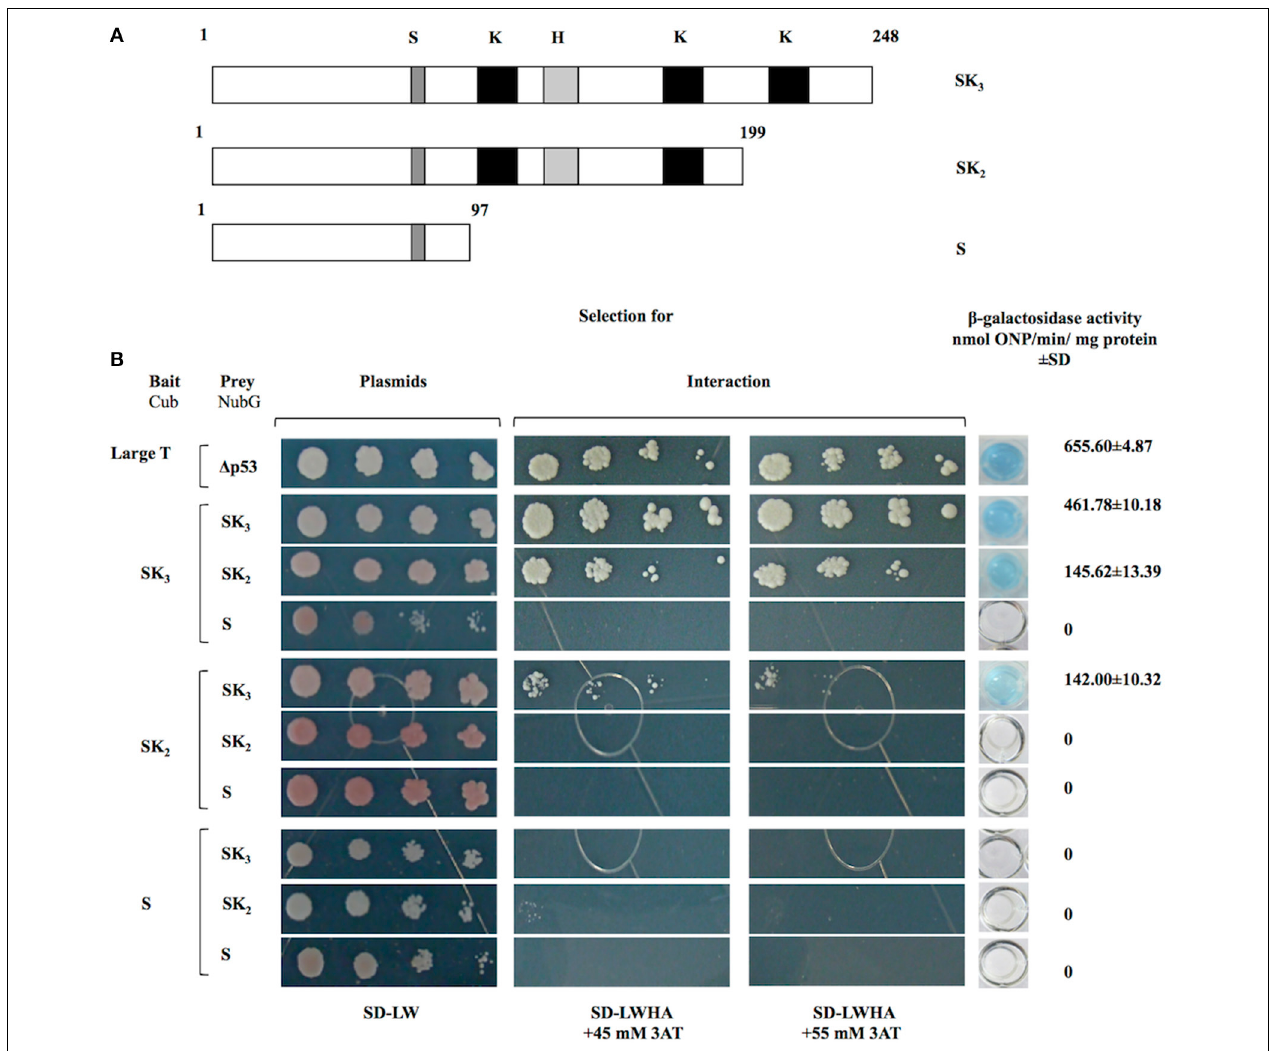
FIGURE 3 | Interaction analyses among OpsDHN1 (SK 3 ) and truncated versions (SK 2 and S) using the split-ubiquitin yeast two-hybrid assay. (A) Schematic representations of OpsDHN1 derived versions used in the two-hybrid split ubiquitin system. OpsDHN1 SK 3 full version; OpsDHN1 SK 2 C-terminal truncated version (residues 1–199); OpsDHN1 S short version (residues 1–97). The capital letters indicates characteristic motifs of OpsDHN1 protein: S (S-segment), K (K-segment), and H (histidine-rich motif). (B) Yeast cells carrying the